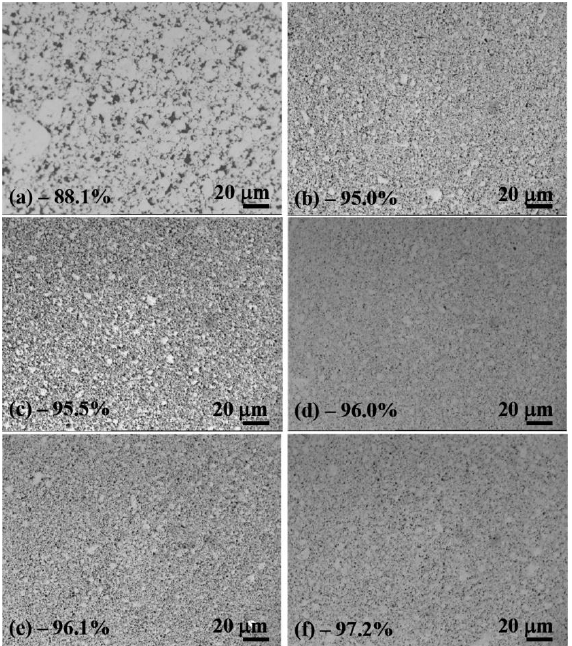
Figure 7. Optical micrographs of polished surface of Al 82 La 10 Fe 4 Ni 4 bulk samples after spark-plasma sintered at ( a ) 543, ( b ) 563, ( c ) 583, ( d ) 603, ( e ) 613, and ( f ) 623 K.